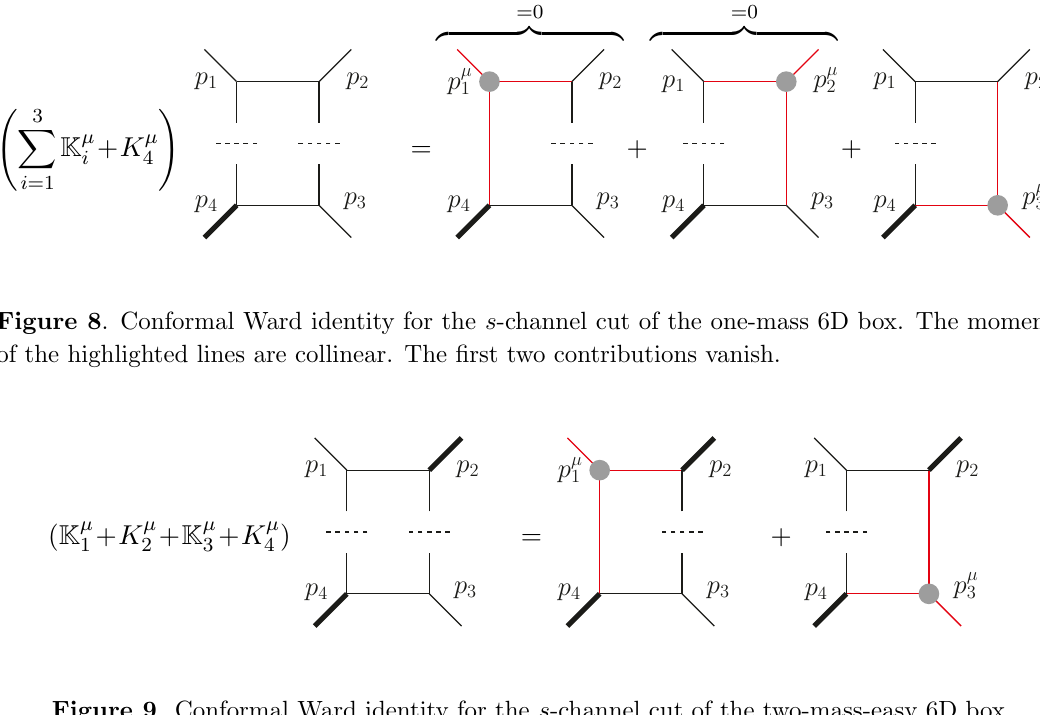
Figure 9 . Conformal Ward identity for the s -channel cut of the two-mass-easy 6D